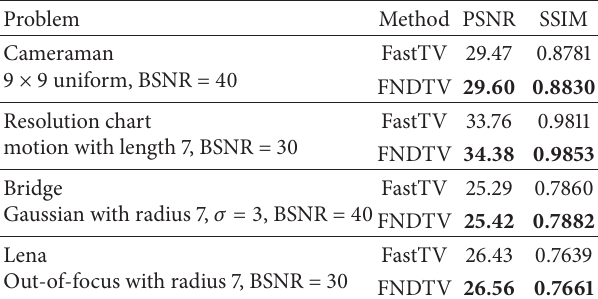
Figure4:Resultsofdifferentmethodswhenrestoringblurredandnoisyimage“Bridge”degradedbyGaussianblurwithradius3andstandard deviation 𝜎 = 3 and a noise with BSNR = 40dB: (a) blurred and noisy image “Bridge”; (b) restored image by FastTV; (c) restored image by FNDTV; (d) SSIM index map of the corrupted image; (e) SSIM index map of the recovered image by FastTV; (f) SSIM index map of the recovered image by FNDTV. Table 1: Numerical results for the experiments in terms of PSNR (dB) and